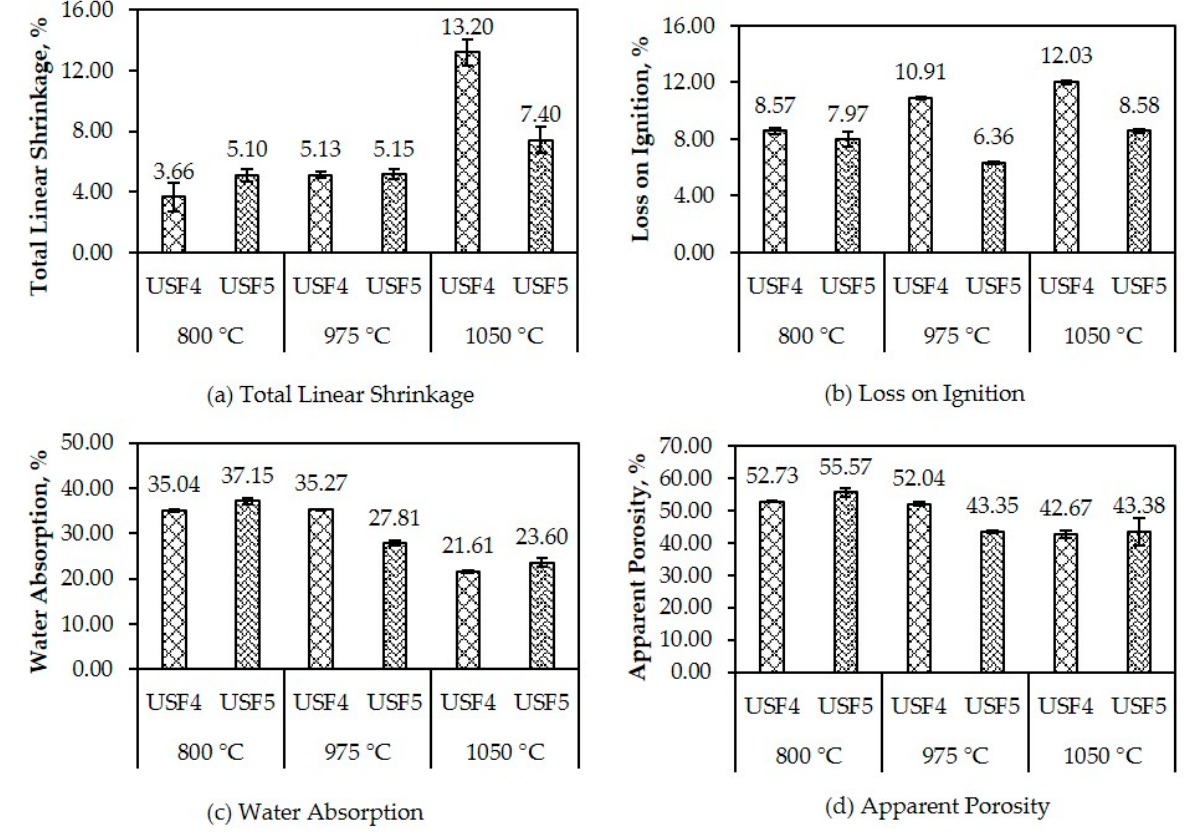
Figure 8. Results on ( a ) shrinkage, ( b ) loss on ignition (LOI), ( c ) water absorption and ( d ) apparent porosity at different temperature.